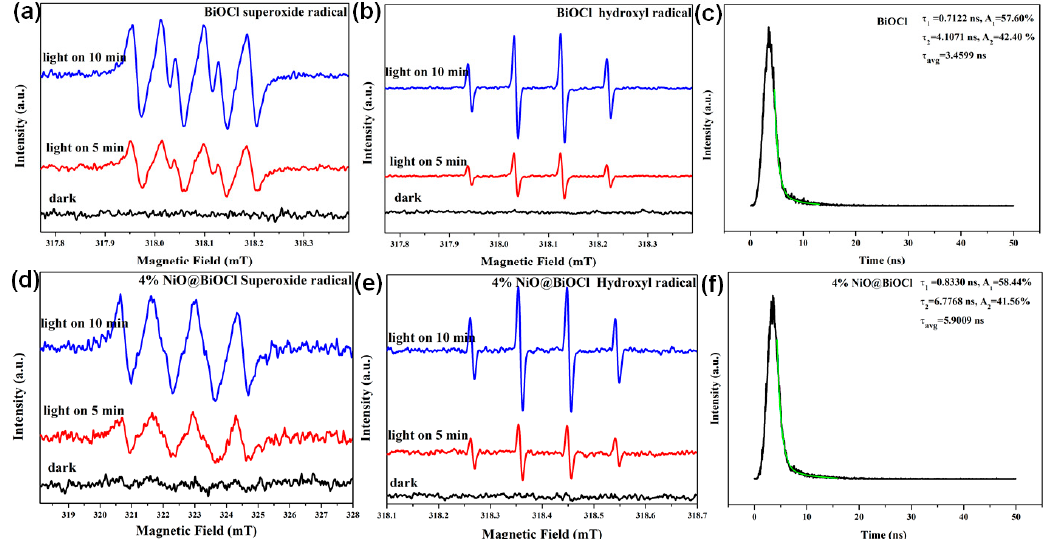
Figure 5. DMPO spin-trapping ESR spectra in BiOCl and 4% NiO@BiOCl in dark or under visible light irradiation: ( a , d ) in methanol dispersion for DMPO-O 2•− ; ( b , e ) in aqueous dispersion for DMPO- • OH. Time-resolved photoluminescence (TRPL) spectra of BiOCl ( c ) and 4% NiO@BiOCl ( f